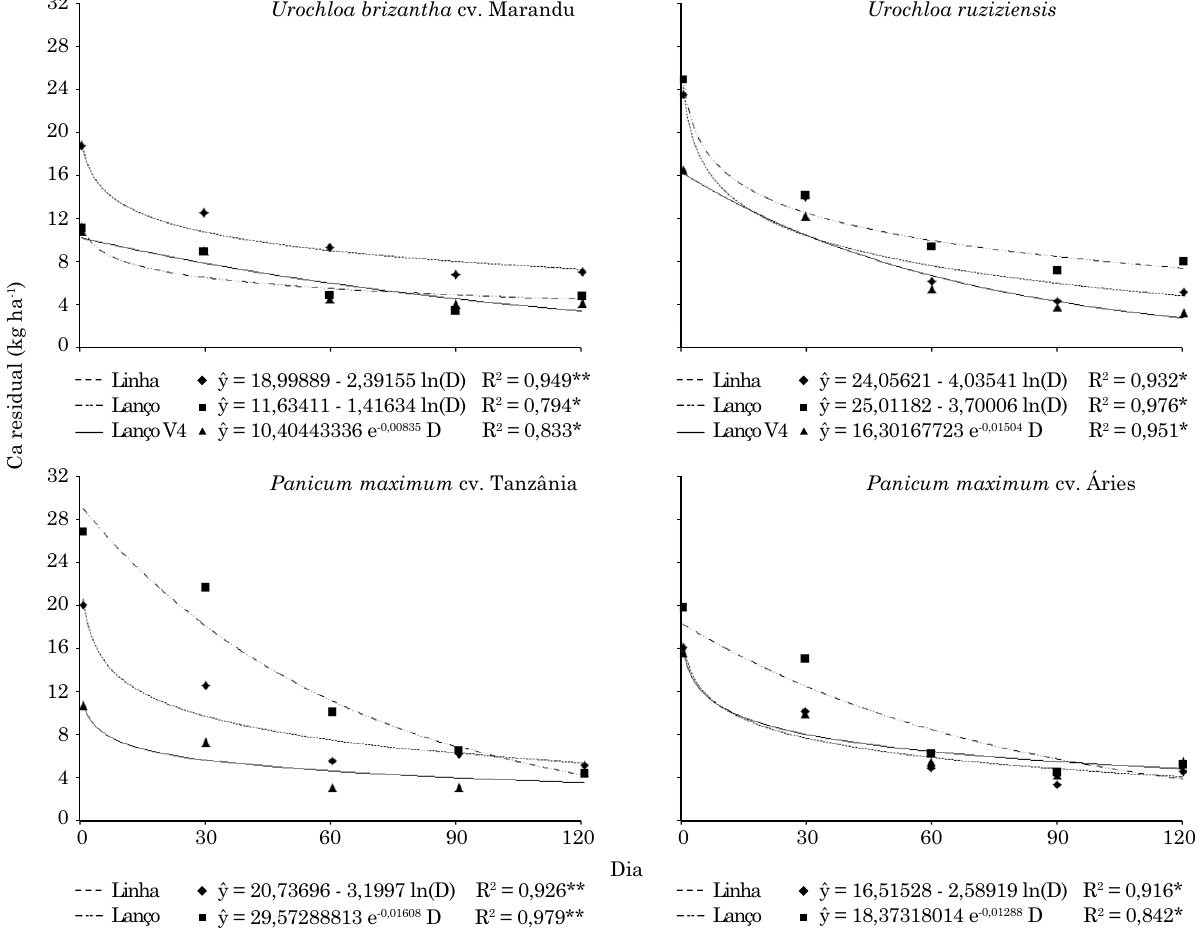
Figura 5. Cálcio residual na palhada das forrageiras remanescente no solo até 120 dias durante o cultivo da soja, para as condições das forrageiras semeadas no plantio do milho, na linha (Linha) ou a lanço (Lanço) ou no estádio V4 a lanço (LançoV4). ** e * p<0,01 e <0,05,